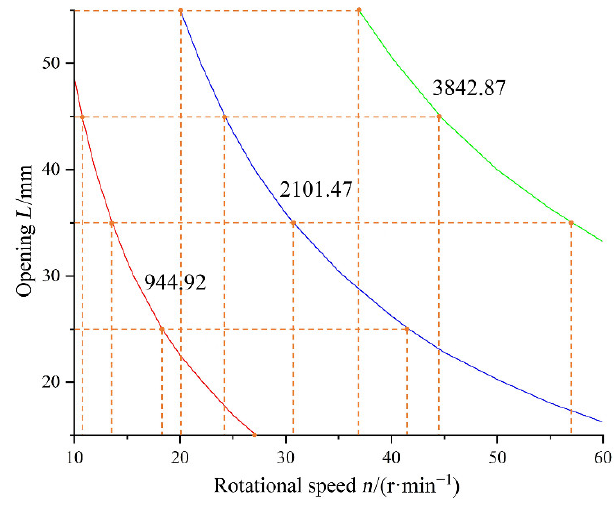
Figure 7. Control sequence selection. Table 3. Control sequence combinations.